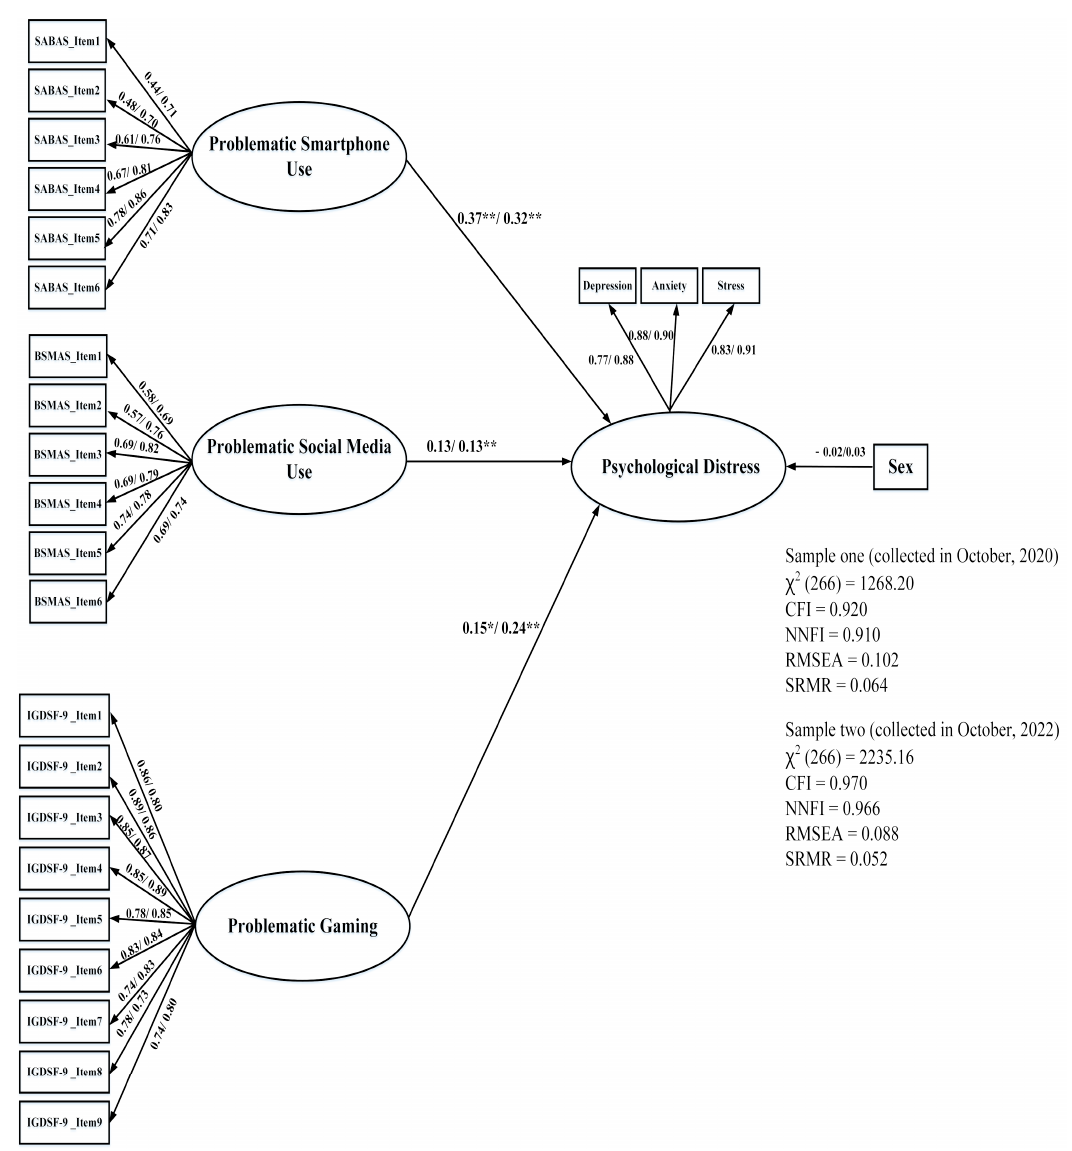
Figure 1. Structural equation modeling of the associations between problematic smartphone use, problematic social media use, and problematic gaming, using the DASS-21. The former and latter values were calculated using the data sets from October 2020, and October 2022. * means p < 0.05, ** means p <